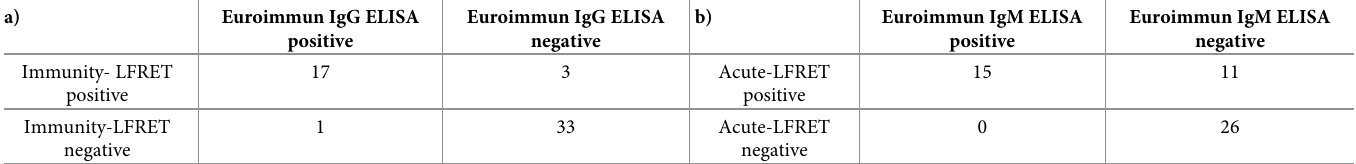
Table 5. Comparison of the outcomes of the Euroimmun ELISA test with class-specific LFRET test outcomes. a)